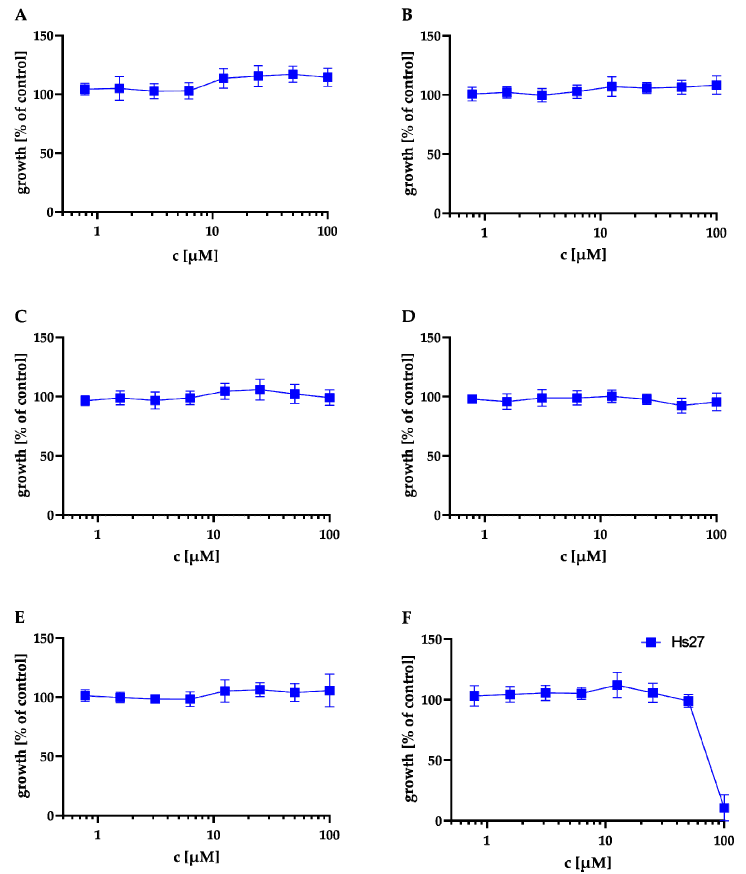
Figure 4. Effect of the natural products on the metabolic activity of Hs27 cells via MTT assay. Hs27 cells were plated in 96-well plates and grown to confluence prior to incubation at 37 °C for 24 h with the natural products in the concentration range of 0.56–100.00 µM. The cultures were incubated with 10 µL of the 12 mM MTT stock solution for approximately 4 h. Afterwards, 100 µL of SDS dissolved in HCl was added to each well and incubated again for 4 h at 37 °C. Finally, the absorbance was measured at 570 nm by spectrophotometry. Values shown in ( A – F ) represent the means of three independent experiments each done in duplicate ( n = 6) ± SEM. Cytotoxicity in Hs27 cells of NK-A 17e233 ( A ); 1,2-benzenediol, 3-(4-hydroxy-2-methoxy-6-methylphenoxy)-5-methyl-(ACI) ( B ); cyperin ( C ); ES-242-1 ( D ); ES-242-3 ( E ); 5 S ,6 S -phomalactone ( F ).